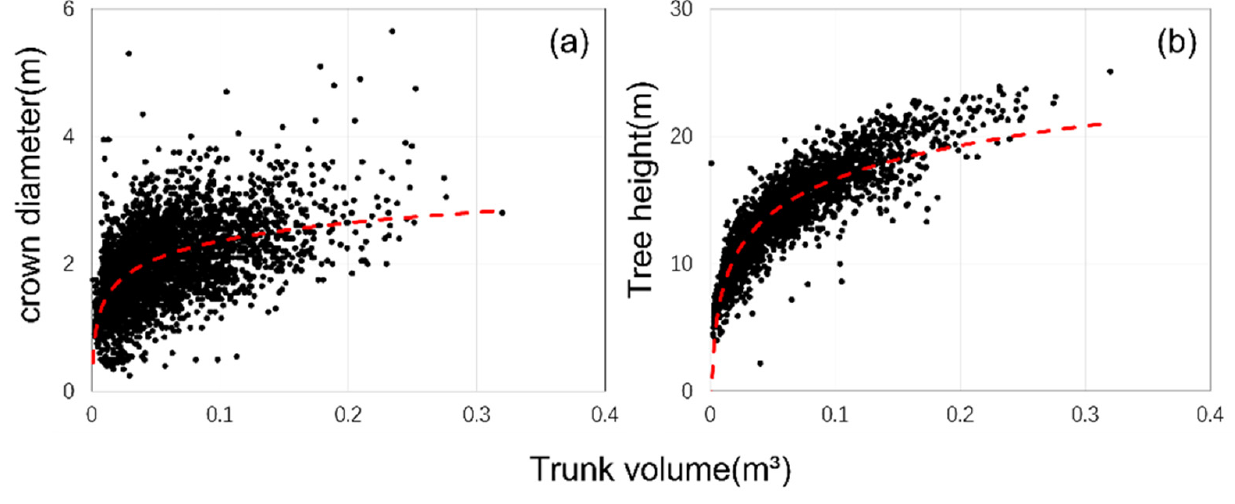
Figure 4. The scatterplots between volume and measured parameters of single tree: the red dash line is the trend line of the scatter, ( a ) is the scatterplot between volume and crown width and ( b ) is the scatterplot between volume and tree height.